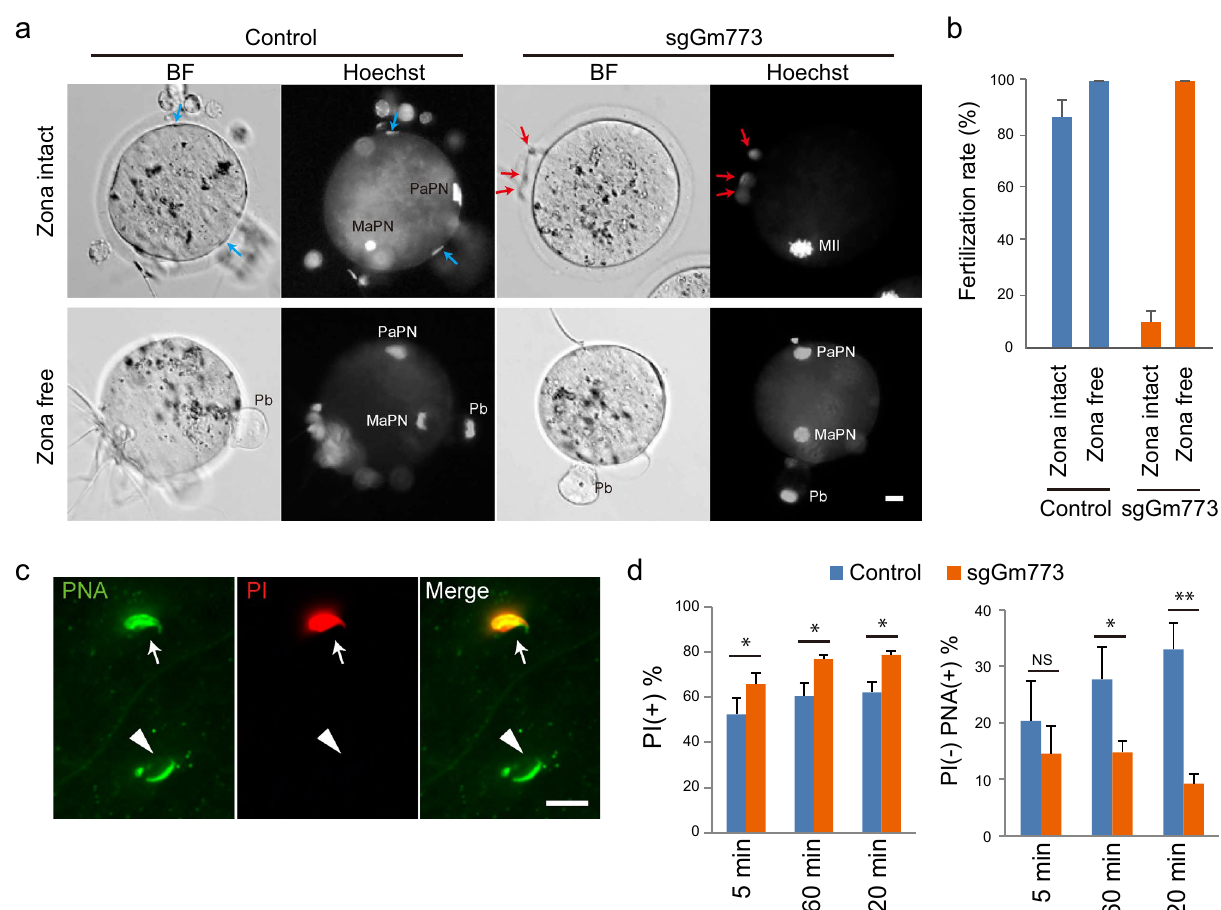
Figure 5. Defects of sgGm773 spermatozoa related to their poor fertility. ( a ) Representative images of oocytes and spermatozoa at 1 h after insemination by IVF. Zona-free oocytes were prepared by brief treatment with acid Tyrode. DNA was stained with Hoechst 33258. Blue arrows, sperm heads penetrated the perivitelline space. Red arrows, spermatozoa stacked on the surface of zona pellucida. BF, bright field; PaPN, paternal pronucleus; MaPN, maternal pronucleus; MII, MII stage spindle; Pb, polar body; Scale bar, 10 μm. ( b ) Bar graphs showing the fertilization rate of control and sgGm773 spermatozoa inseminated with zona intact or zona- free oocytes. The fertilization rate remained at less than 10% when sgGm773 spermatozoa were inseminated with zona intact oocytes and increased to 100% when zona pellucida was removed. ( c ) Representative images of sperm head stained with PI or PNA. Arrows indicate PI(+) spermatozoon. Arrowheads indicate PI(−)/ PNA(+) spermatozoon. Scale bar, 10 μm. ( d ) Bar graphs showing the percentage of PI(+) and PI(−)/PNA(+) spermatozoa at the indicated time points of